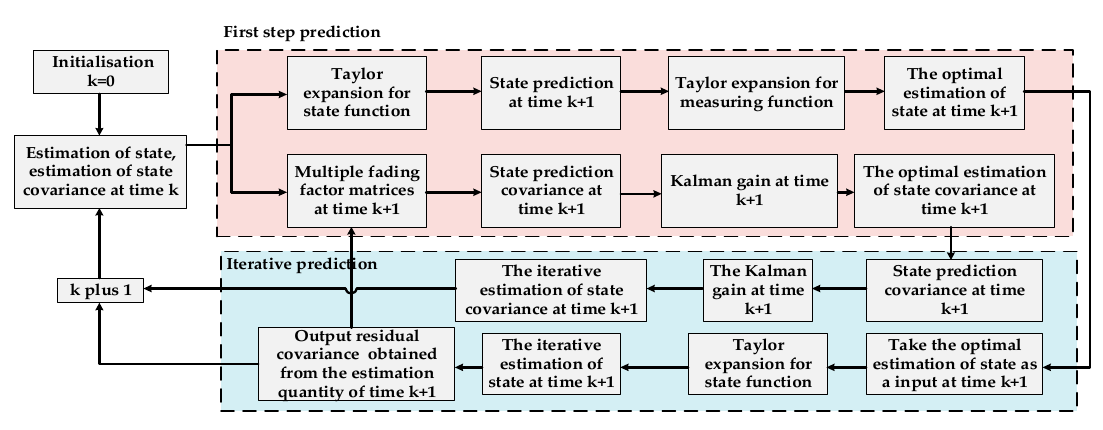
Figure 7. Procedure of improved extended Kalman filtering (IEKF).